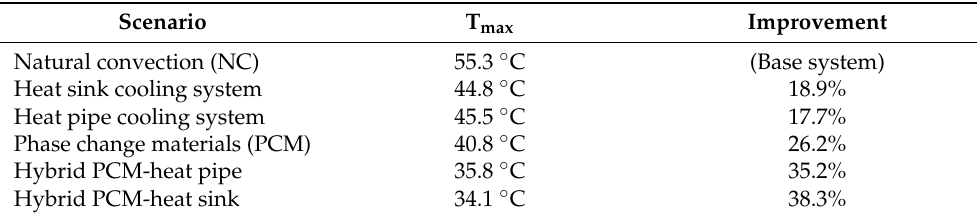
Table 3. Temperature comparison of the LiC for different scenarios.